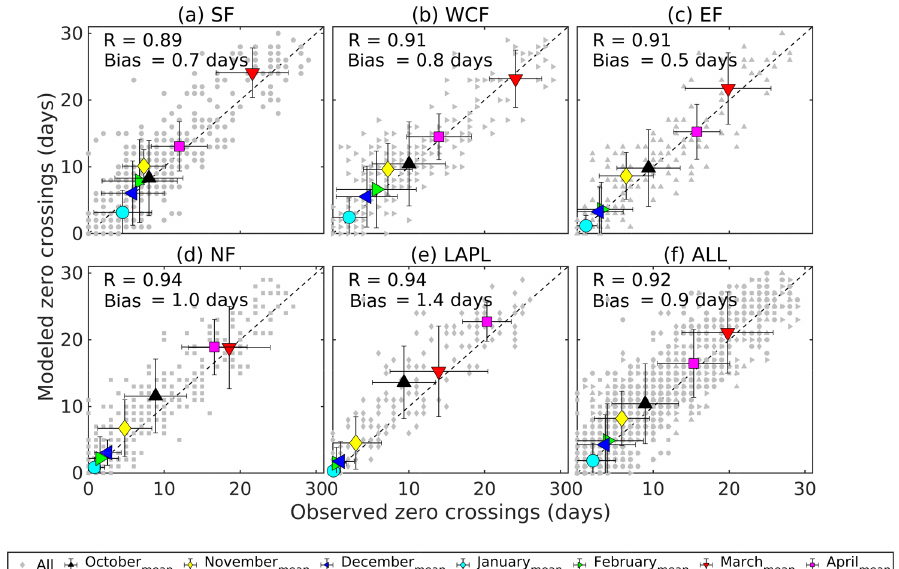
Figure 11. Modeled vs. observed days per month when road temperatures had been both below − 0 . 5 ◦ C and above 0.5 ◦ C (zero-crossing day) during October and April in 2002–2014 in (a) Southern Finland (SF), (b) Western and Central Finland (WCF), (c) Eastern Finland (EF), (d) Northern Finland (NF), (e) Lapland (LAPL), and (f) the whole of Finland (ALL). Grey color represents the monthly values for every year and the multiyear monthly means are illustrated in other colors. The vertical and horizontal bars represent ± 1 standard deviation based on 13 years of monthly values from the model and observations, respectively. R stands for the Pearson correlation coefficient and BIAS for the mean difference between the modeled and observed values. The dashed black line represents a 1 : 1 reference line.